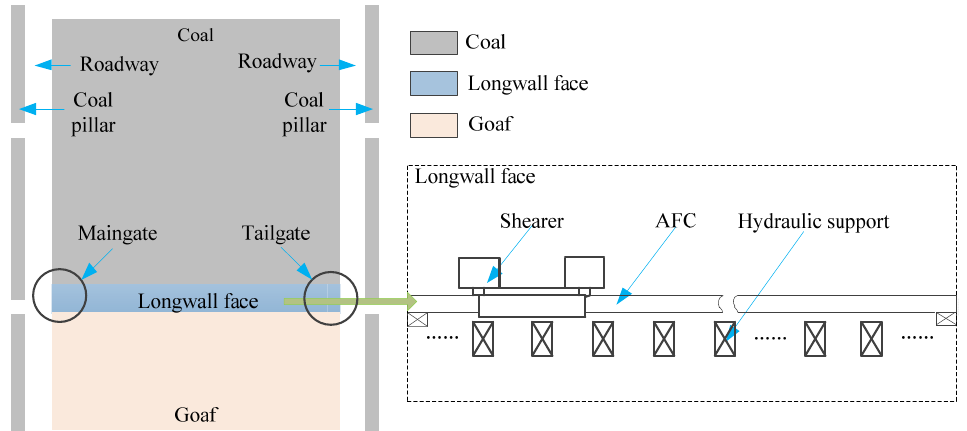
Figure 1. A top view of a longwall panel and composition of a longwall face.